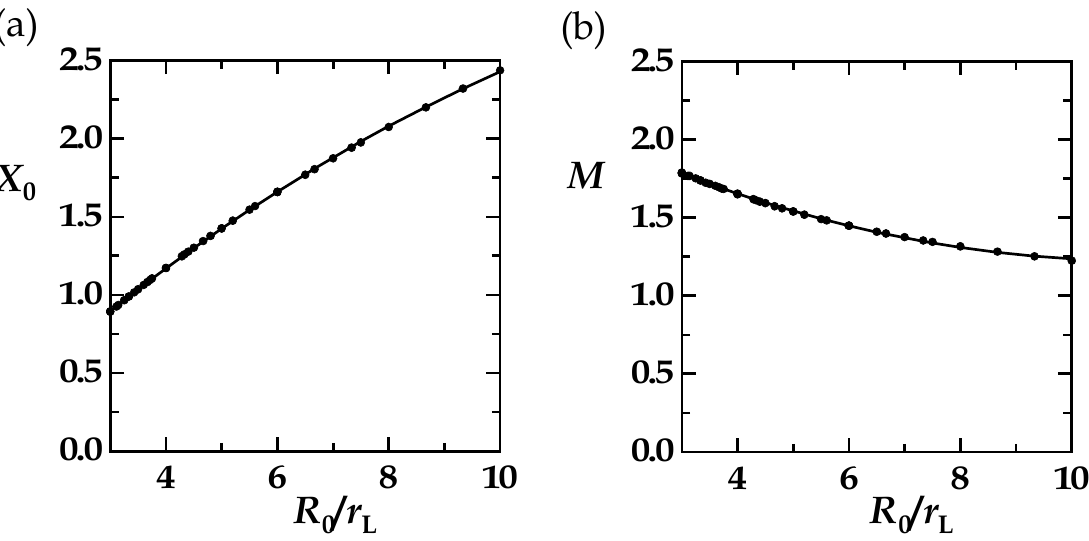
Figure 7. The results for X 0 and M (solid circles in panels ( a , b ) obtained for the range of R 0 = 9–15 Å, r L = 1.5–5 Å with b = 2 R 0 , and R 0 / r L > 3) were fitted to second-degree polynomial functions (solid lines in panels ( a , b ) given in Table 2).